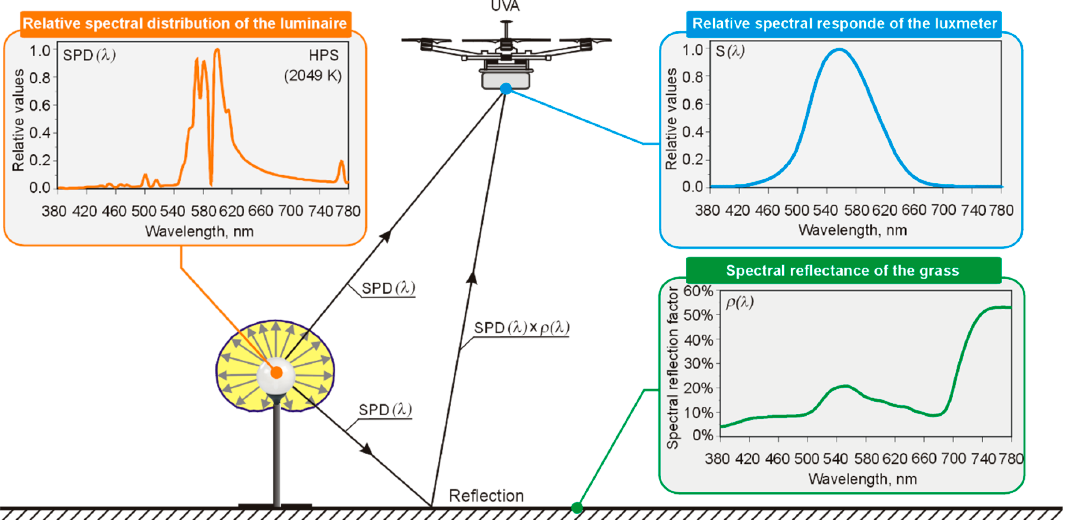
Figure 10. Illustrative visualization of the radiation that reaches the luxmeter placed on the deck of the UAV.